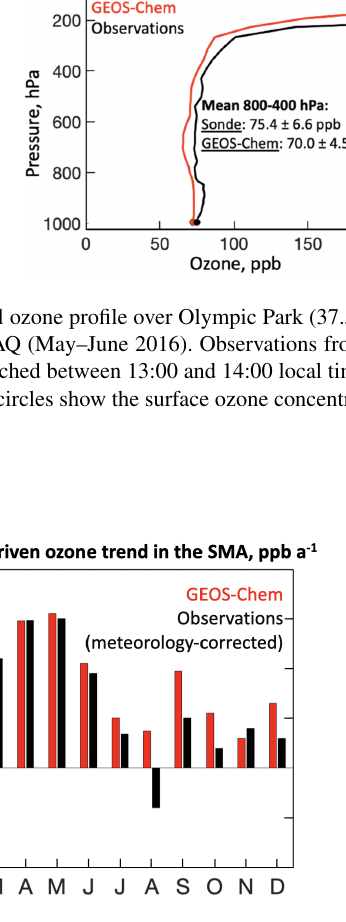
Figure 10. Emission-driven trends in 90th percentile MDA8 ozone from 2015 to 2019 in the Seoul metropolitan area (SMA) for in- dividual months. The observed meteorology-corrected trend is as shown in Fig. 5. The modeled trend is obtained by subtraction of results from simulations with 2015 and 2019 emissions, both using the same 2016